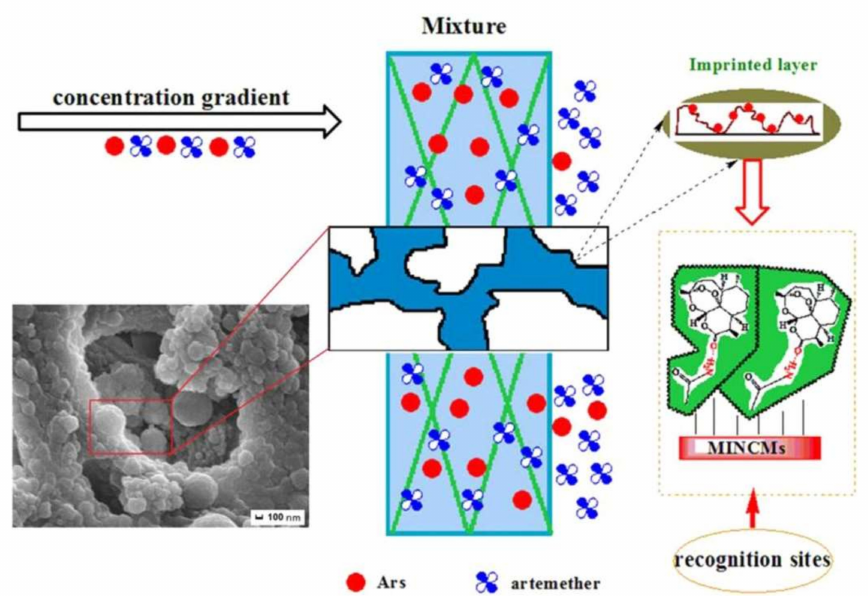
Figure 14. Separation mechanism for artemisinin and artemether toward composite cryogel membranes. Republished with permission from [80]. Copyright 2015 Elsevier.